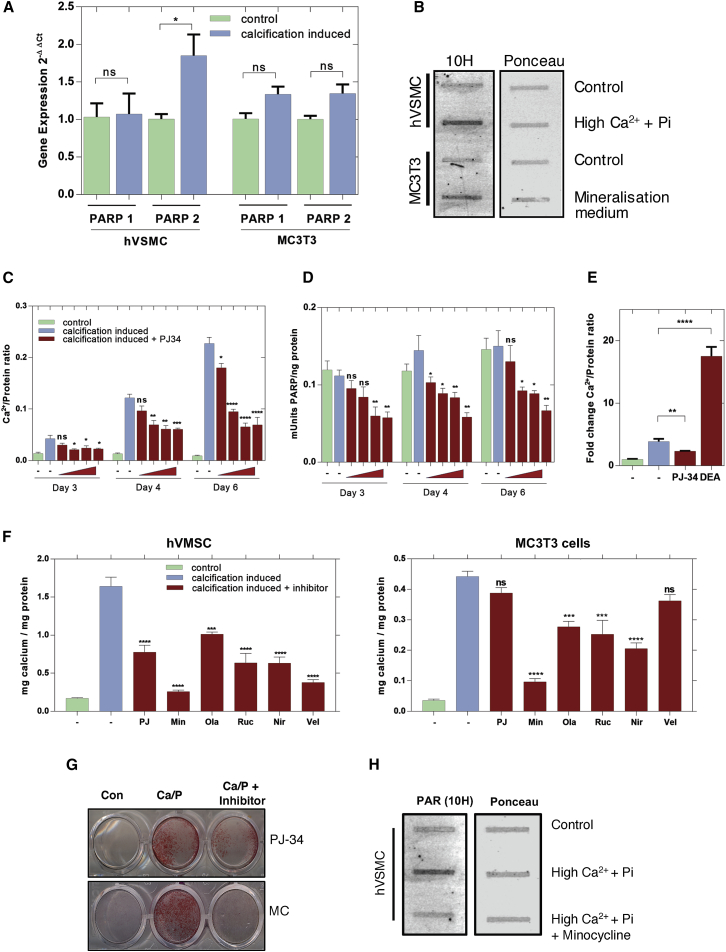
PARP Inhibitors Decrease Calcification of hVSMCs In Vitro(A) qRT-PCR analysis of hVSMCs and MC3T3 cells in vitro shows expression of PARP1 and PARP2 enzymes in control cultures. hVSMC cultures under calcifying conditions show increased expression of PARP2 (n = 3).(B) Slot blot of hVSMC and MC3T3 cells under calcifying conditions showing increased PAR.(C) The o-cresolphthalein assay (n = 3) showed a time-dependent increase in mineralization, which was inhibited in a dose-dependent manner by the PARP inhibitor PJ-34 (0.5, 1.5, and 10 uM).(D) PARP activity was reduced by PJ34 treatment in a dose-dependent manner (n = 4) in hVSMC cultures. See Figures S6A and S6B for data on bVSMC model.(E) The PARG inhibitor DEA (0.1 mM) increased calcification of hVSMCs treated with high Ca/P media quantified by o-cresolphthalein. (n = 6). Mean ± SEM, Student’s t test, ∗∗p < 0.01, ∗∗∗∗p < 0.0001.(F) PARP inhibitors can block calcification of hVSMCs (n = 3) and MC3T3 (n = 6) cells. PJ = PJ-34, Min, minocycline; Ola, Olaparib; Ruc, Rucaparib; Nir, Niraparib; Vel, Veliparib; all are at 3 μM. See Table S2 for enzyme inhibitor assay details and Figure S6C for details on minocycline as a PARP1/2 inhibitor.Graphs in (A), (C), (D), and (F) show mean ± SEM. Statistical significance was tested with one-way ANOVA with Dunnett’s post hoc tests. ∗p between p < 0.05, ∗∗p < 0.01, ∗∗∗∗p < 0.0001.(G) Alizarin Red S staining of mineral in hVSMC cultures in the absence and presence of PARP inhibitors PJ-34 (3 μM) and minocycline (3 μM).(H) Slot blot showing increased PAR under calcifying conditions and its inhibition by minocycline (3 μΜ).